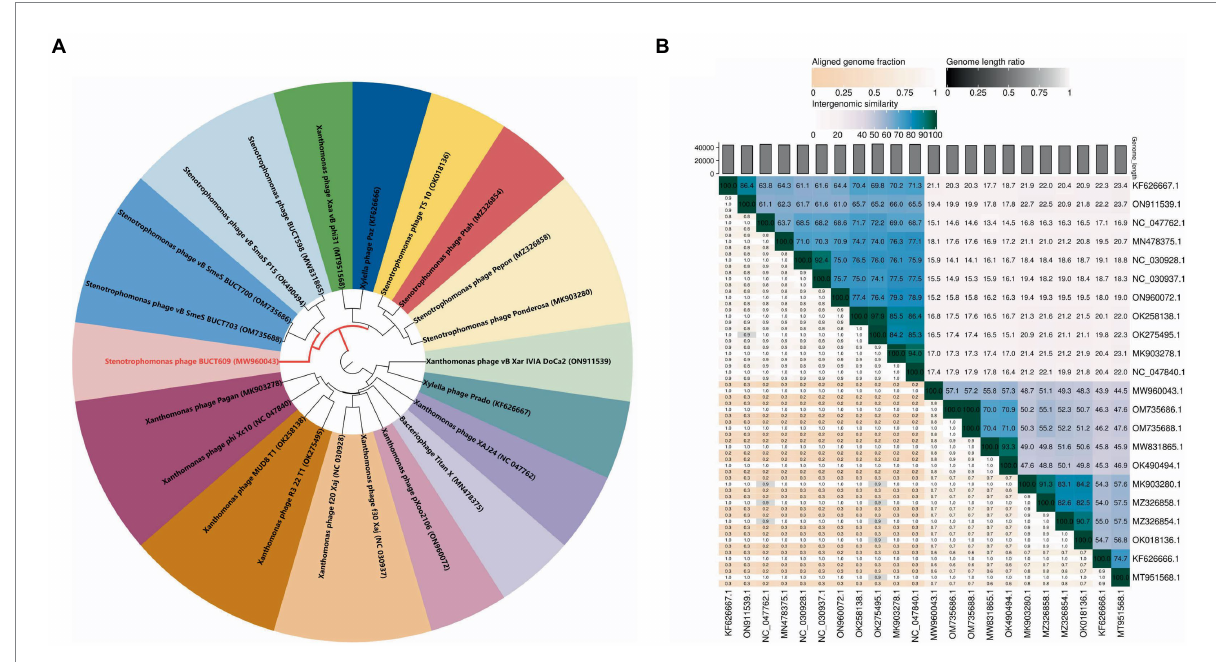
FIGURE 4 Phylogenetic analysis of phage BUCT609. (A) A phylogenetic tree was constructed based on the whole genome sequence by VICTOR which indicated phage BUCT609 could be a new species. (B) Percentage sequence similarity between phages calculated using VIDIRIC which shows phage BUCT609 could be a new clade. The horizontal and vertical coordinates indicate the corresponding phage Genebank